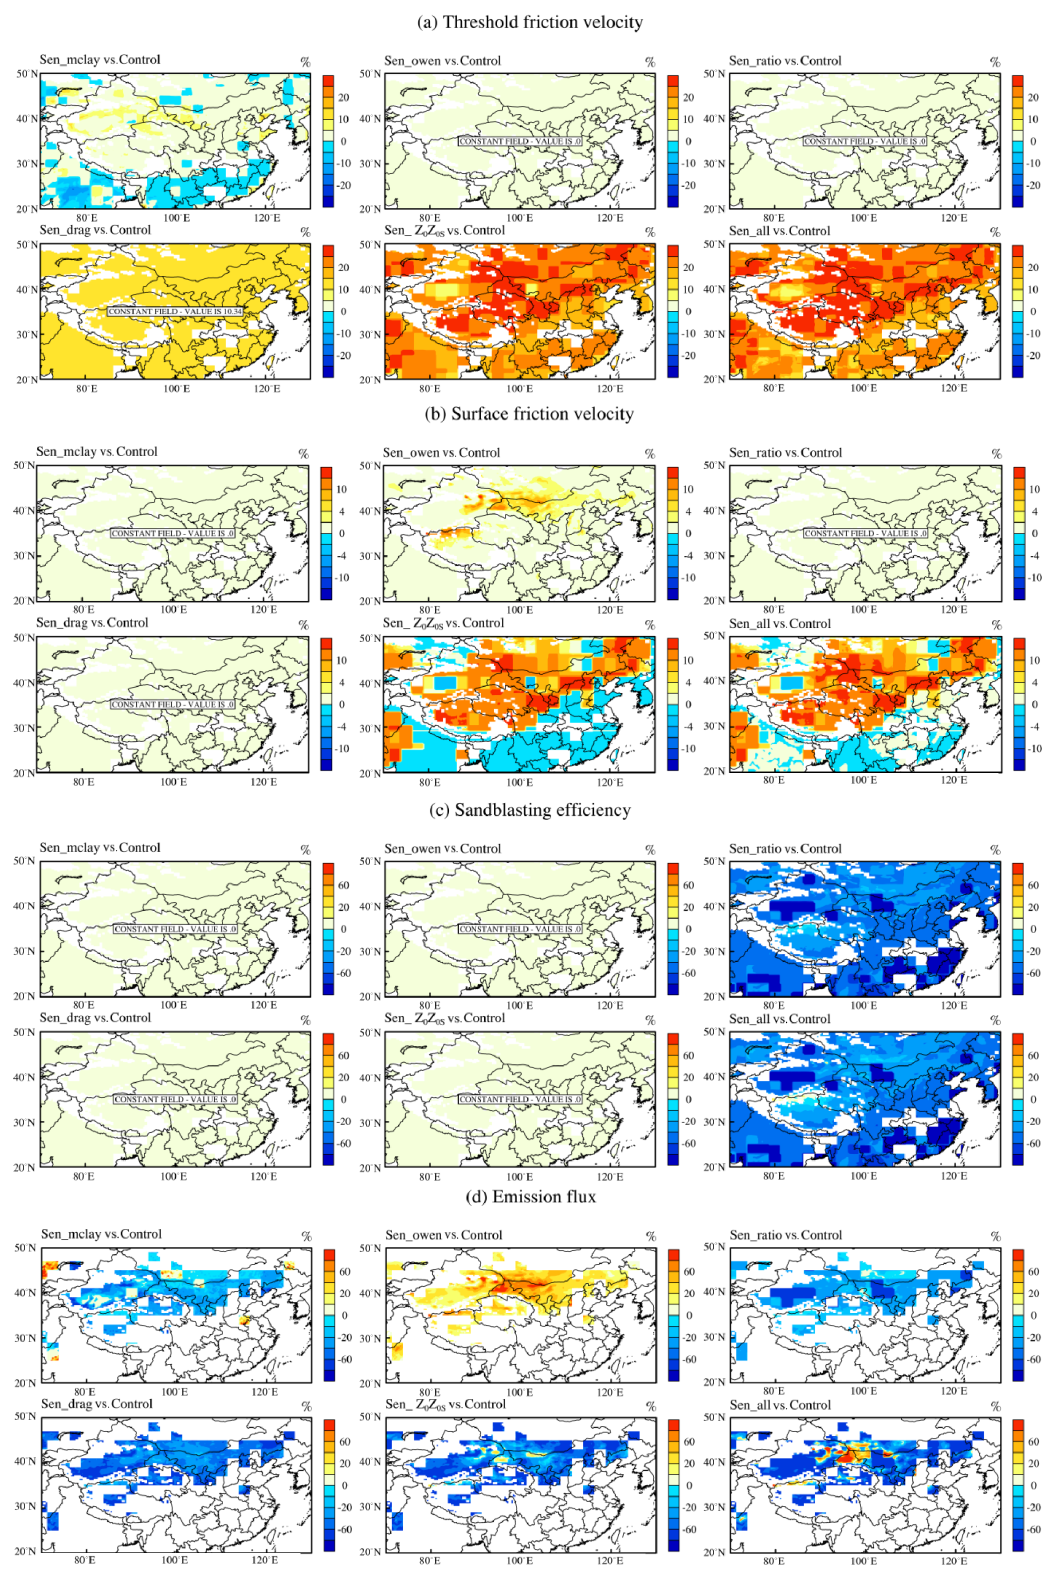
Figure 7. Relative difference (%) in simulated averaged threshold friction velocity u ∗ t (a) , surface friction velocity u ∗ (b) , sandblasting efficiency α (c) and emission flux (d) between sensitivity simulations and the control run during the study period.